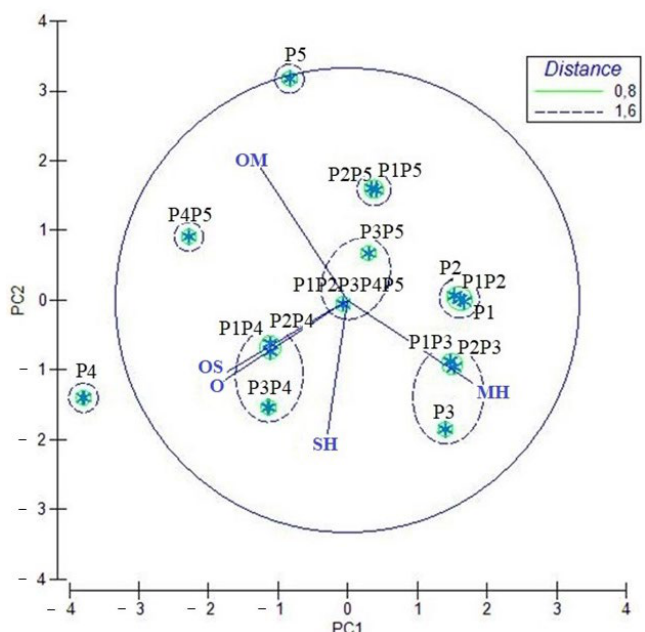
Figure 2. Principal component analysis (PCA) of EOs from C. maxima and their mixes based on the principal classes of compounds: monoterpene hydrocarbons (MH), oxygenated monoterpenes (OM), sesquiterpenes hydrocarbons (SH), and oxygenated sesquiterpenes (OS), and others (O). The vectors shown are the eigenvectors of the covariance matrix. The samples’ codes are reported in Section 2.1: Plant Material.